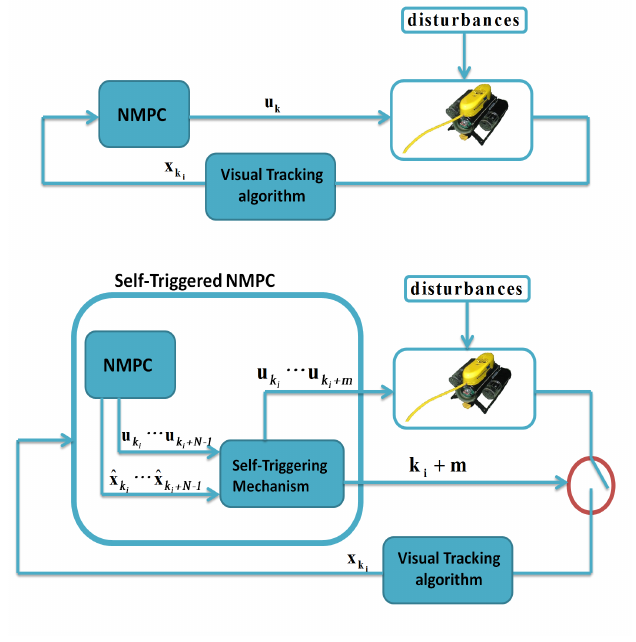
Figure 1. The classic periodic time-triggered framework is depicted in the top block diagram. The bottom diagram represents the self-triggered